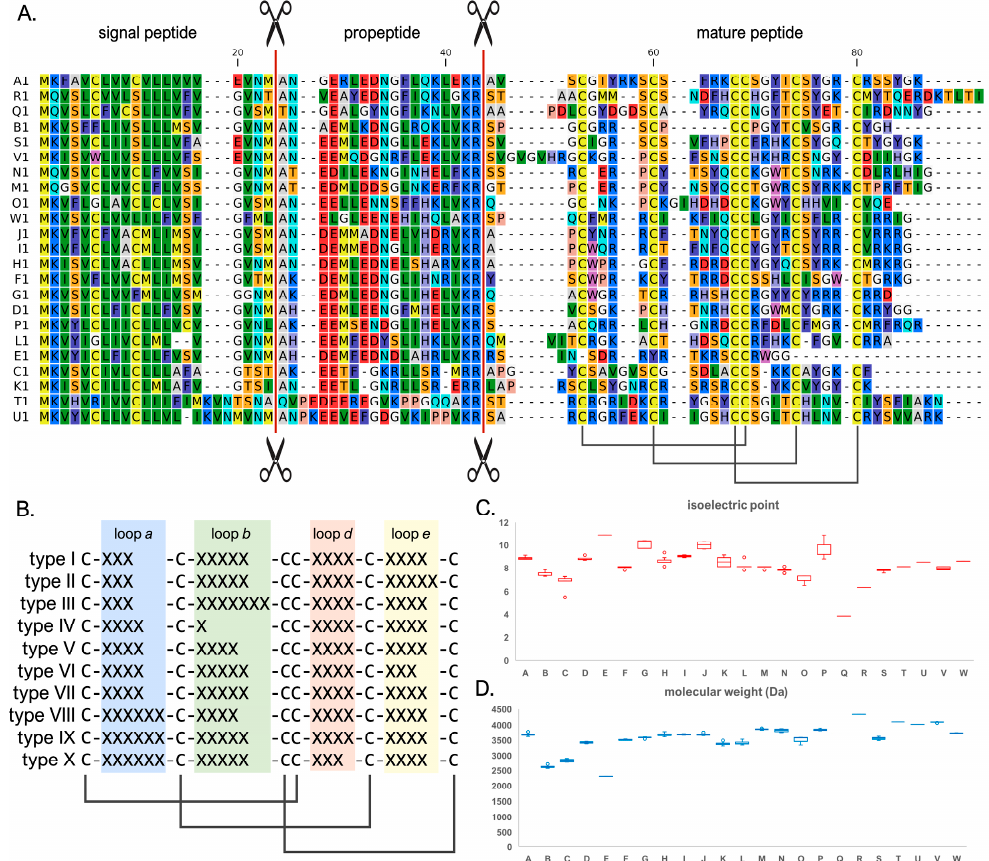
Figure 1. Panel ( A ): multiple sequence alignment of the full-length protein precursors of representa- tive members of each of the 23 sCRP-I sequences. The inferred position of the signal peptide and propeptide cleavage sites are marked by scissors. The inferred disulfide connectivity between the six highly conserved cysteine residues involved in the establishment of the knottin fold is indicated at the bottom of the mature peptide region. Panel ( B ): schematic representation of the ten types of cysteine arrays characterizing sCRP-I peptides. Loop a, b, d and e indicate the four loops connecting conserved cysteine residues in the primary sequence of knottins. Note that loop c is missing due to the neighboring position of Cys3 and Cys4. Panel ( C ): isoelectric point (mean plus standard deviation, outliers are indicated by circles) of the mature peptide sequences of each sCRP-I group (indicated by uppercase letters). Panel ( D ): molecular weight (mean plus standard deviation, outliers are indicated by circles) of the mature peptide sequences of each sCRP-I group (indicated by uppercase